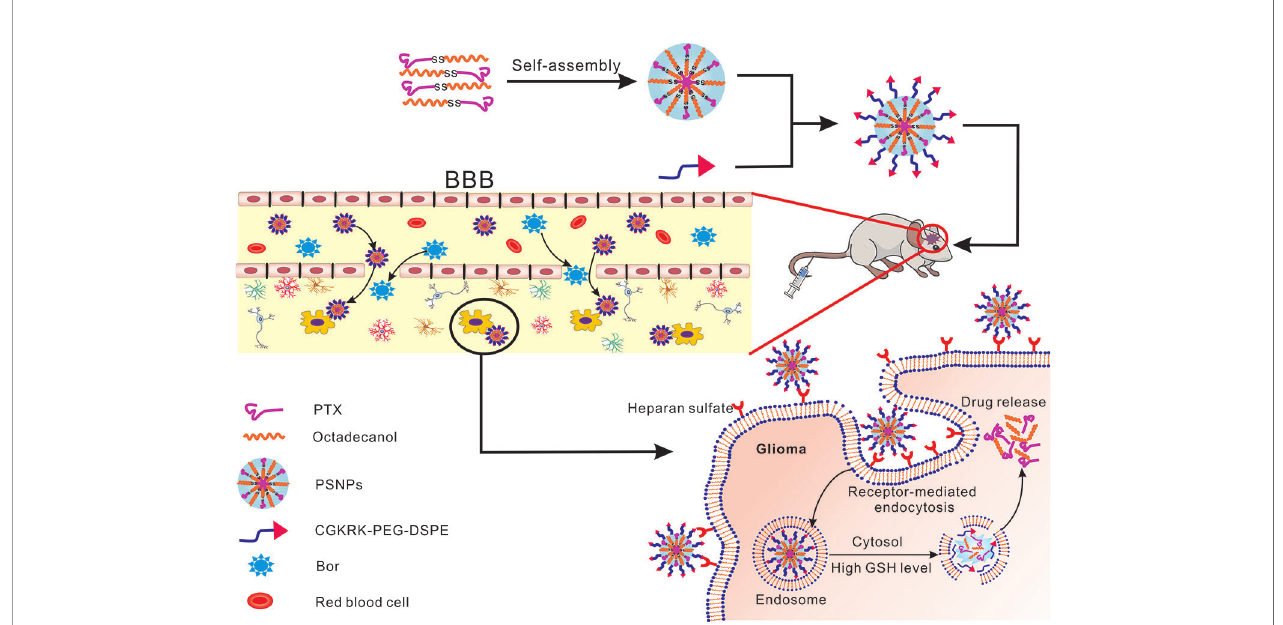
FIGURE 1 | Schematicofborneol combined with CGKRK modi fi ed PTX-SS-C 18 conjugate self-assembled targetednanoparticles (CGKRK-PSNPs) for glioma